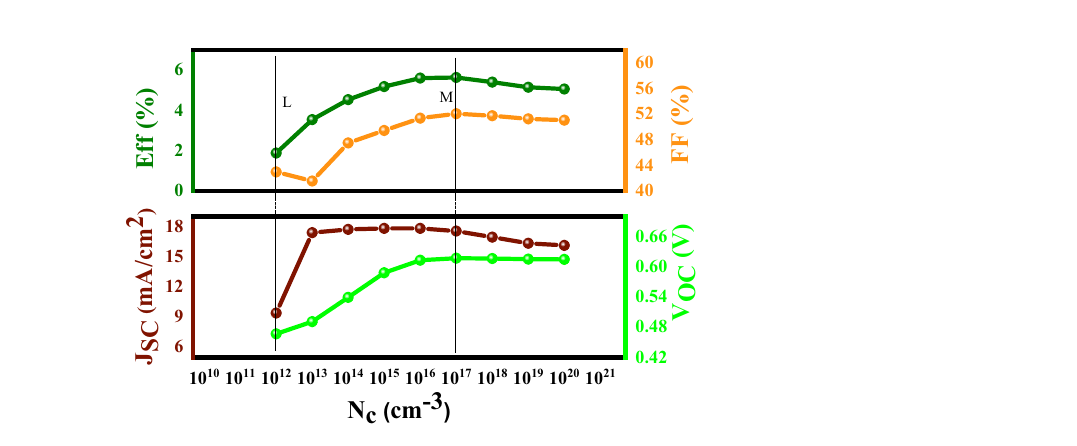
Figure 10. Variation of the solar cell parameters of the CBT (S, Se) solar cells with different thicknesses of the In 2 S 3 layer.